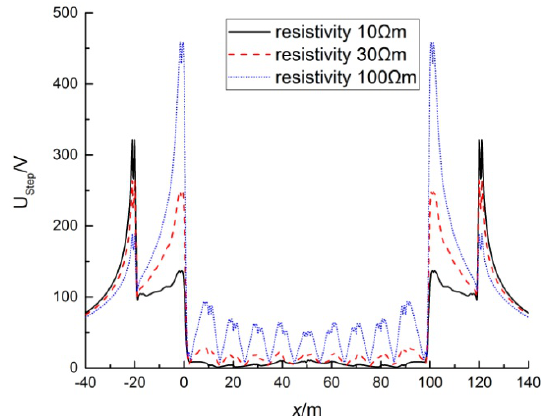
Figure 6. The change in step voltage with resistivity.